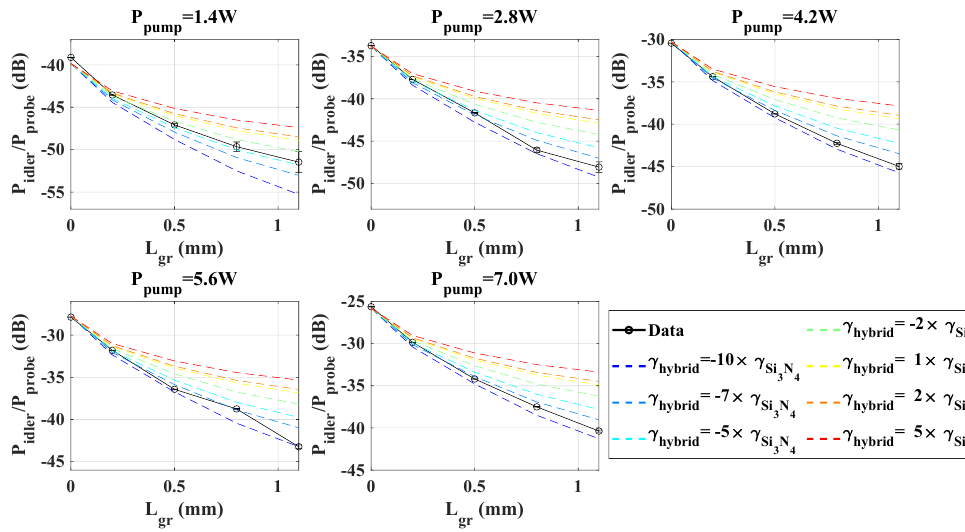
Figure 5. Measured CE (in black) as per Equation (2), versus the graphene length for different peak pump powers (in each subfigure). The dashed lines correspond to the simulation results, each considering a different nonlinear parameter for the hybrid graphene/ Si 3 N 4 section (expressed in = 1m − 1 W − 1 units of γ Si 3 N 4